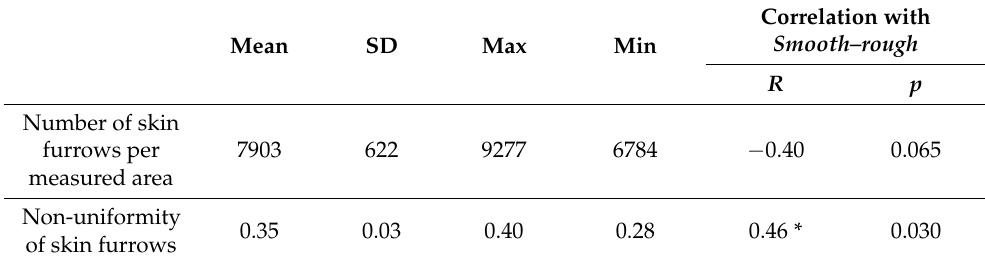
Correlation with Smooth–rough R p